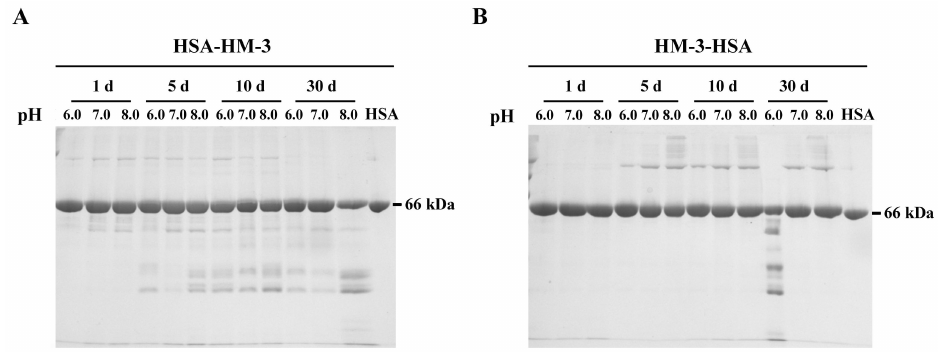
Figure 3. Stability of HSA-HM-3 ( A ) and HM-3-HSA ( B ) at different pH after being stored at 37 ◦ C for 1, 5, 10, and 30